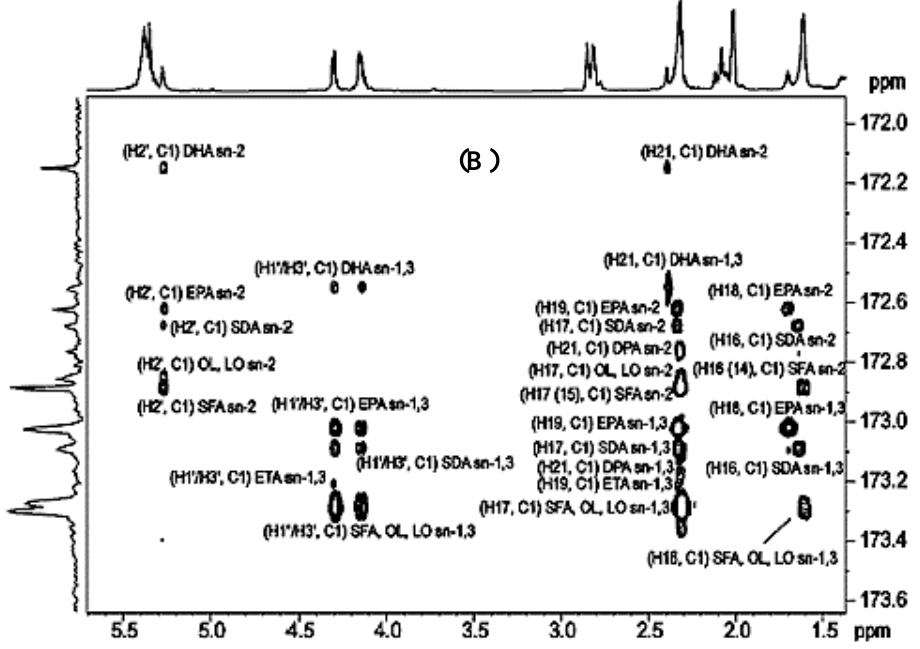
Figure 22. Comparison of the 850 MHz 1 H- 13 C gHMBC spectrum of a fish oil supplement acquired over a 200 ppm spectral width ( A ) and the band selective constant time HMBC spectrum of the same sample acquired with a 2 ppm spectral width ( B ), in CDCl 3 solution. Adopted, with permission, from [60]. Copyright 2015, Royal Society of Chemistry.